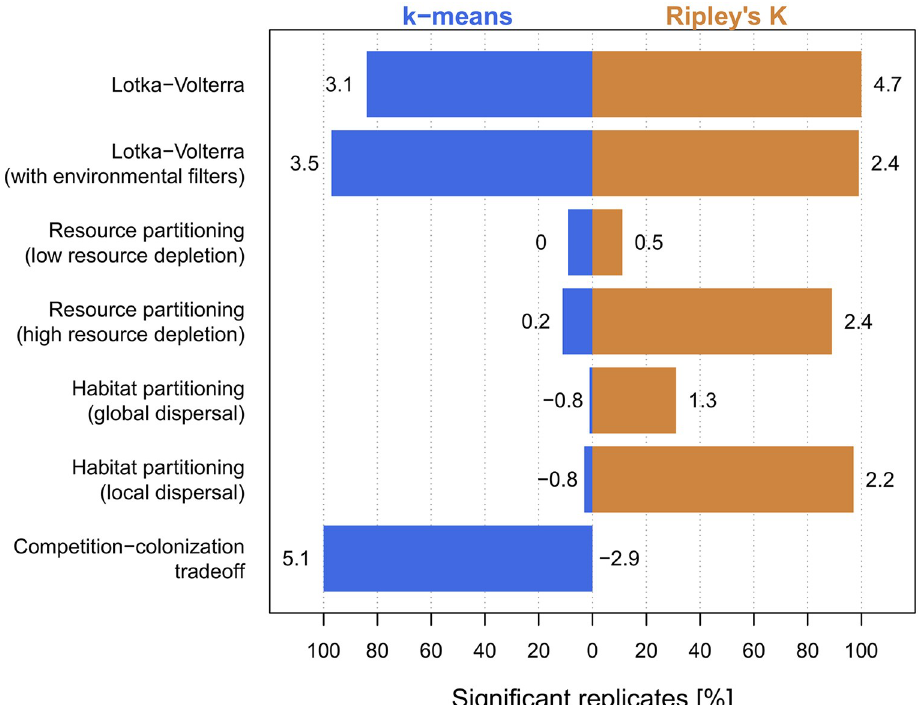
Fig 3. Clustering across niche mechanisms. Bars show percentage of replicates that were significantly clustered at level p < 0.05 according to the k-means metric (blue) and the Ripley’s K metric (orange), out of 100 replicates. Numbers next to bars show average z-score. For comparison, 8% of neutral communities were clustered by the k- means metric ( Z ¼ 0 : 07 ), and 7% by the Ripley’s K metric ( Z ¼ (cid:0) 0 : 12 ), thus close to the 5% background detection expected from a null model (z-scores and p-values were obtained by comparing each replicate against 100 null communities. m = 0.08, c. 400 regional species across